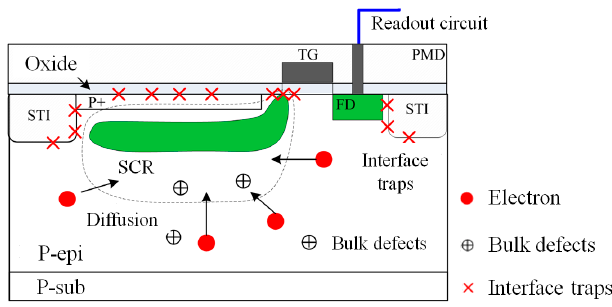
Figure 7. Main defects leading to dark current increase after proton radiation.